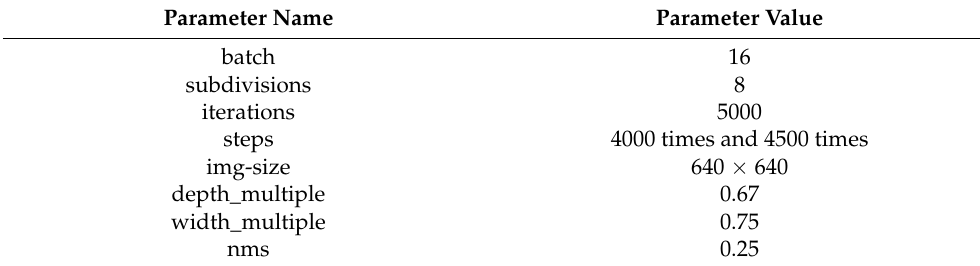
Table 1. Training parameter